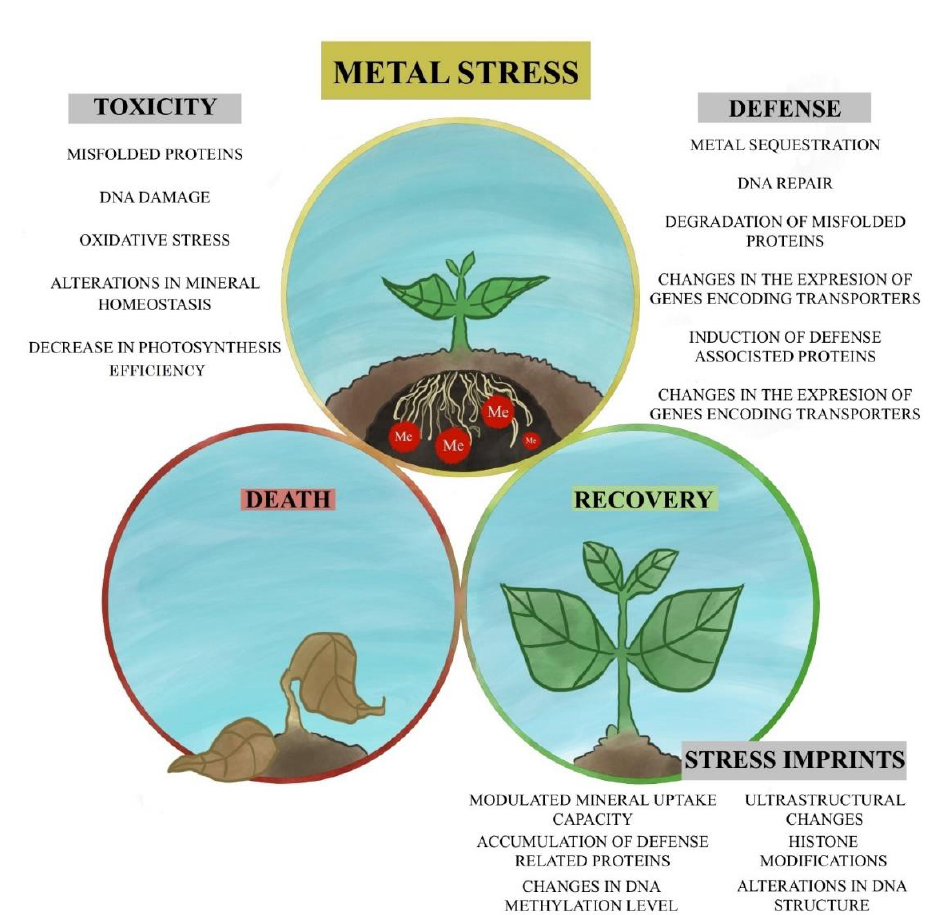
Figure 1. Metal toxicity might cause severe injuries and result in plants death. On the other hand, exposure to metals stimulates defense mechanisms, which enable plant survival and efficient recovery after stress termination. Past stress conditions might leave relatively stable imprints that influence future plant performance in negative or positive manner. The figure has been prepared by Jorge Granados-Tello (jorgegranadostello@gmail.com) and is published with his